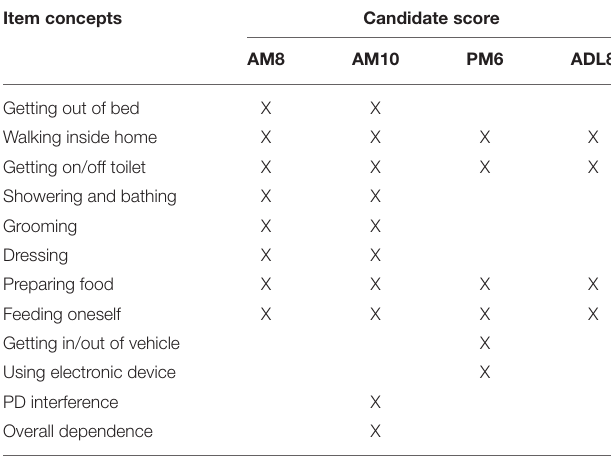
TABLE 2 | Potential PD-AID